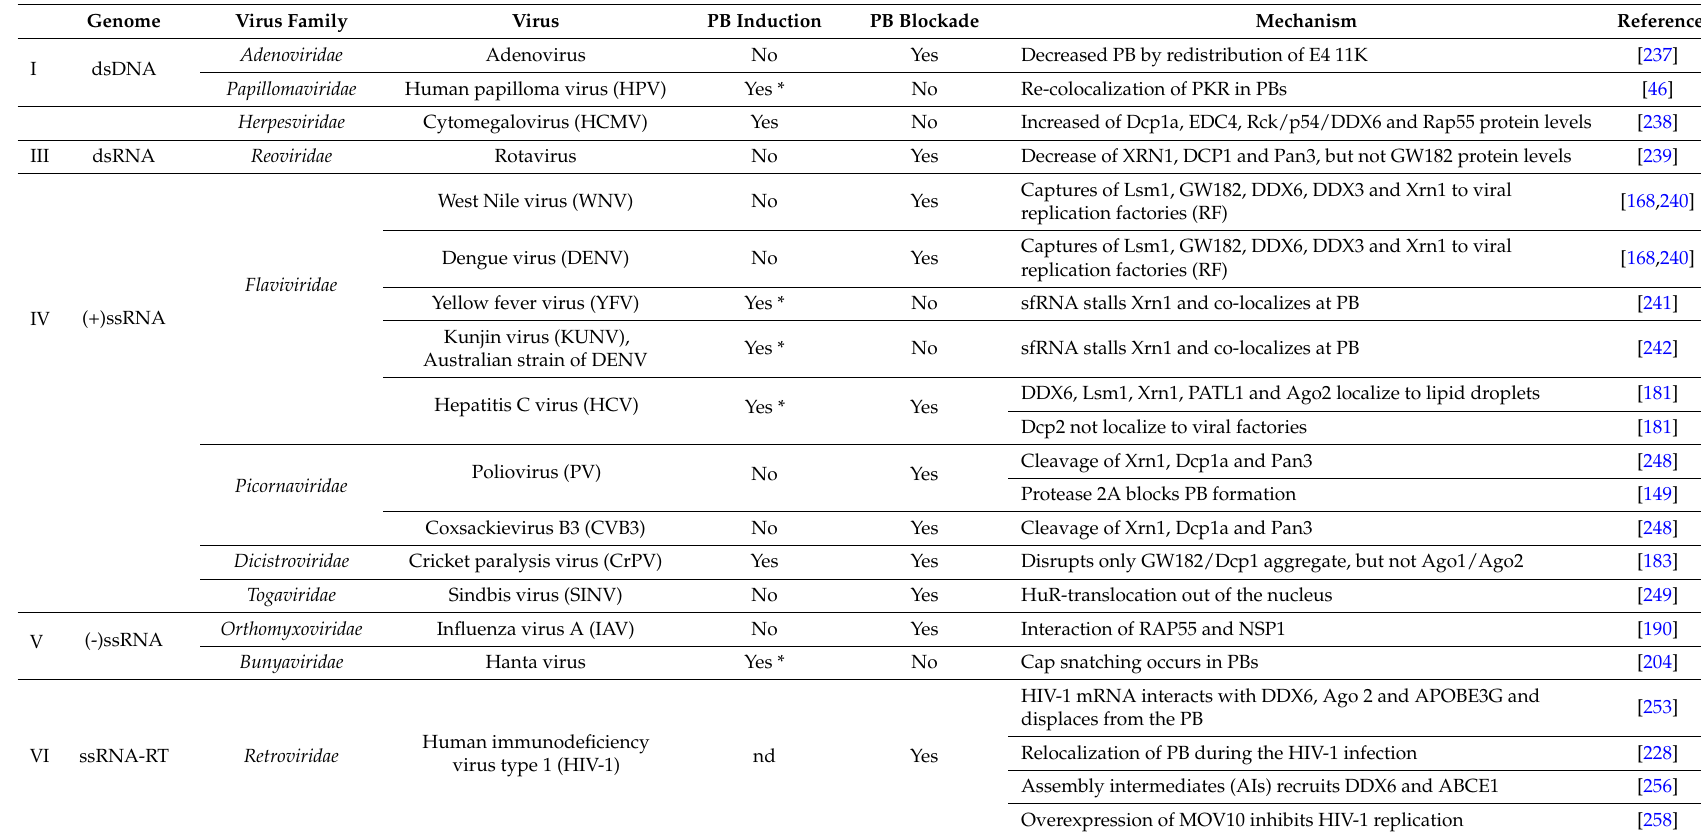
Table 3. Virus families that modulate